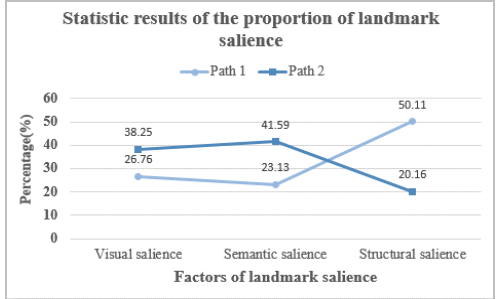
Figure 4. Statistic results of the proportion of landmark salience included experimental